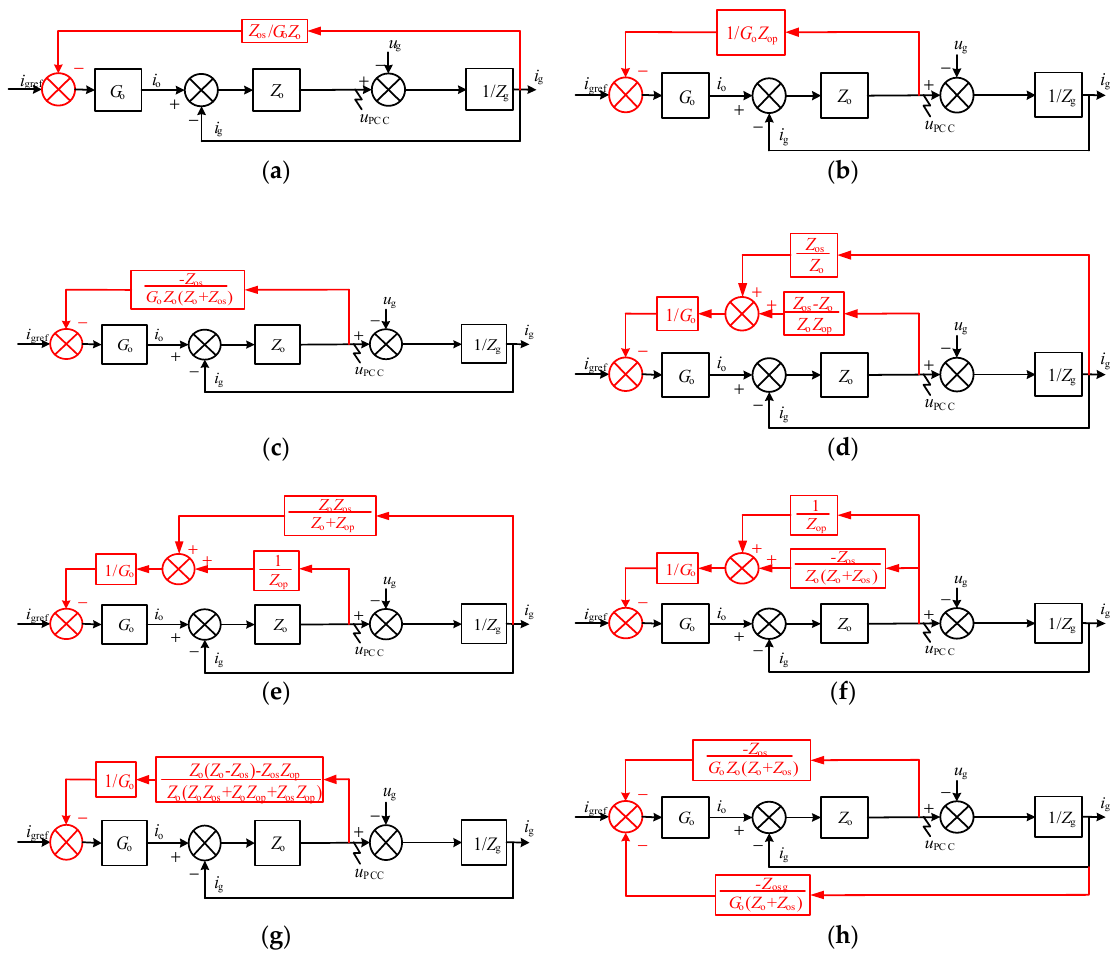
Figure 4. Methods of reshaping output impedance based on control loops: ( a , c ) series reshaping; ( b ) parallel reshaping; ( d – h ) combination of series and parallel reshaping.